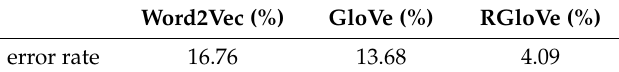
Table 1. Error Table 1. Error rates. Table 1. Error rates.